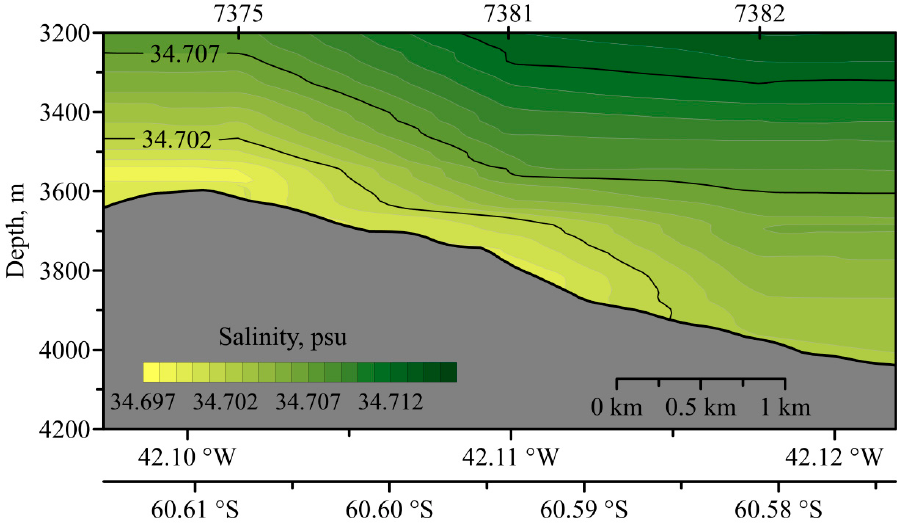
Figure 9. Salinity distribution over the downslope section of the Orkney Passage.